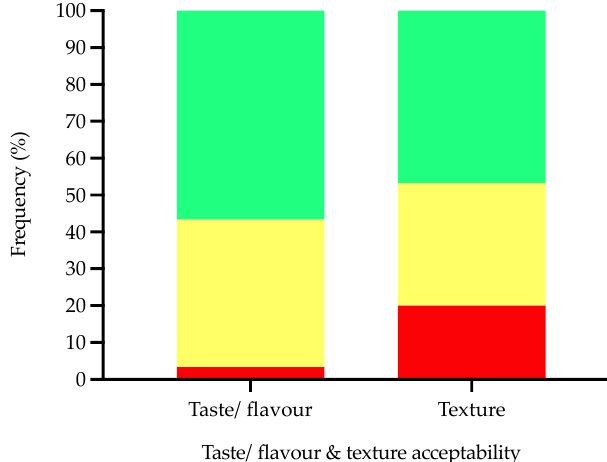
Figure 7. Consumers commonly consumed protein-fortified products ( n = 30; consumers only an- swered this question if they regularly consume protein-fortified products). Data expressed as per- centages with differing small letters reflecting significance from post hoc analysis.